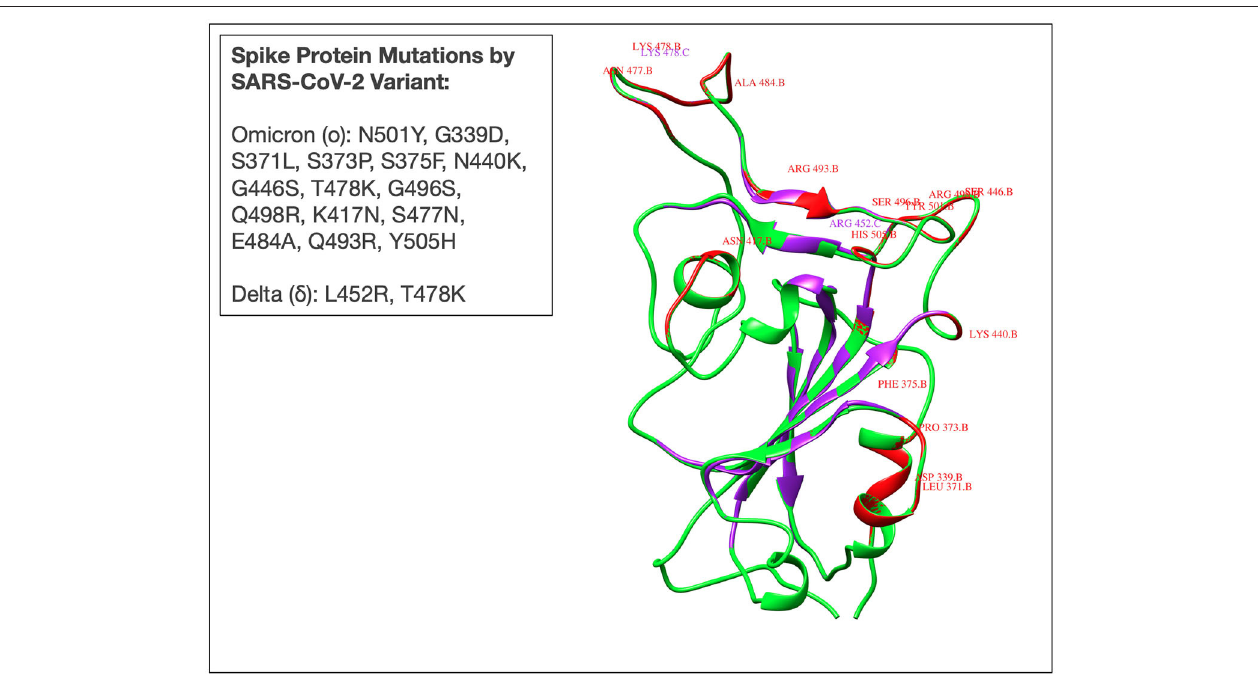
FIGURE 1 | Superimposed three-dimensional (3D) structure of the receptor binding domain (RBD) of spike protein derived from Omicron (B.1.1.529), Delta (B.1.617), and Wuhan (ancestral- D614G) SARS-CoV-2 variants. Red and purple colours reflect the omicron and delta RBD, respectively. The Wuhan RBD is represented by a green colour. Mutations in delta (L452R, T478K), and omicron (N501Y, G339D, S371L, S373P, S375F, N440K, G446S, T478K, G496S, Q498R, K417N, S477N, E484A, Q493R, Y505H) are also represented by corresponding colours. Mutant 3D models for delta and omicron variants were generated using UCSF